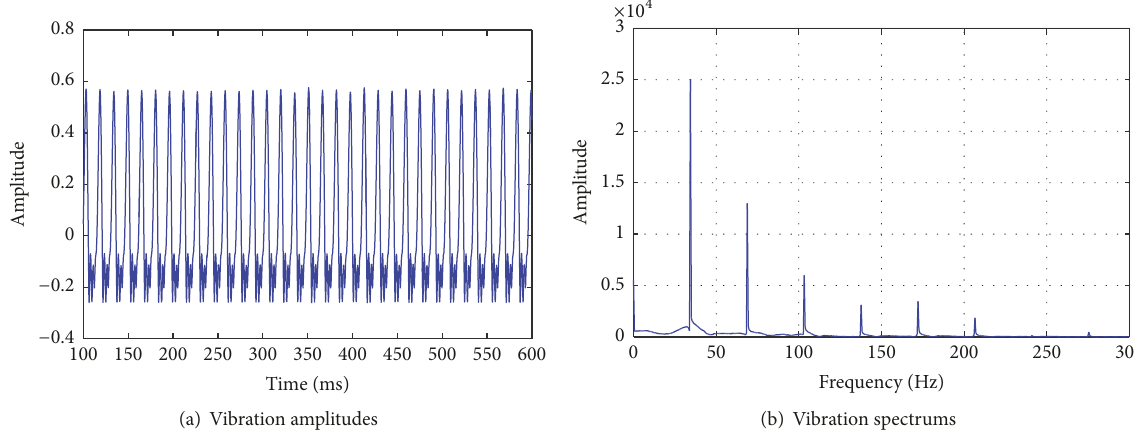
Figure 11: The horizontal direction response of the position of pedestal looseness ( 𝜆 = 0.5 , 𝛿 = 0.00002 m).